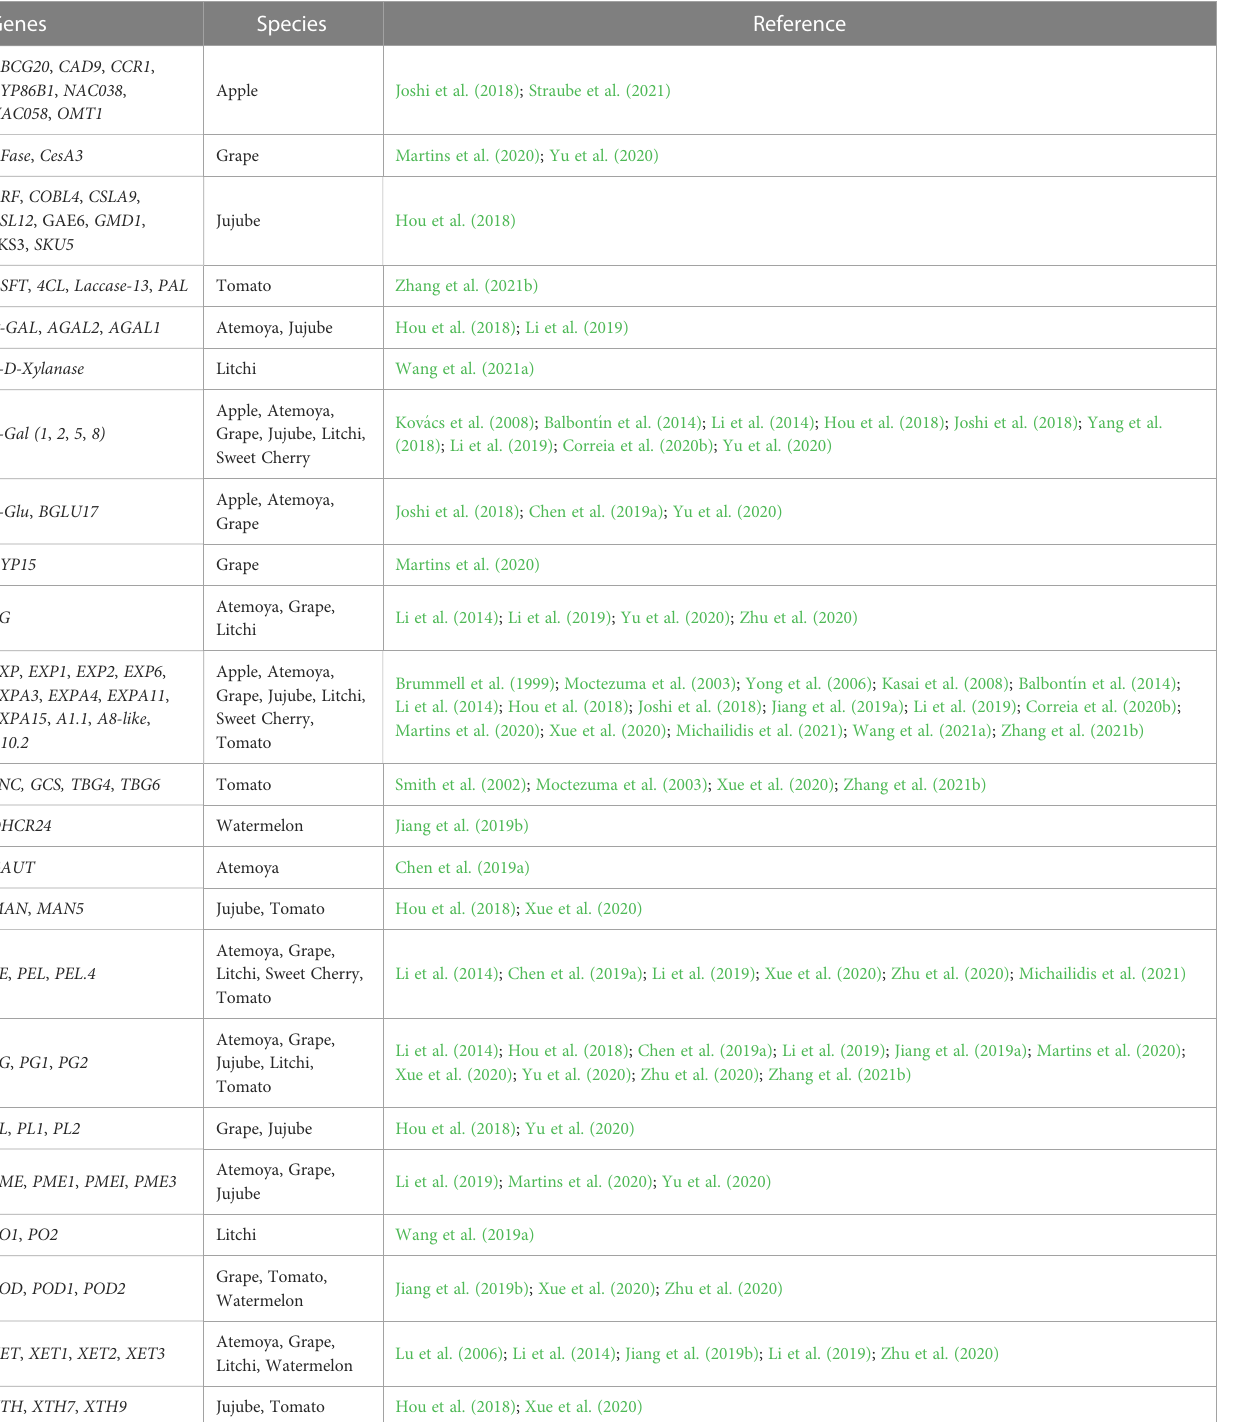
TABLE 1 Potentially cracking-related genes involved in metabolisms of cuticular membrane, cell wall, suberin and lignin biosynthesis. Genes